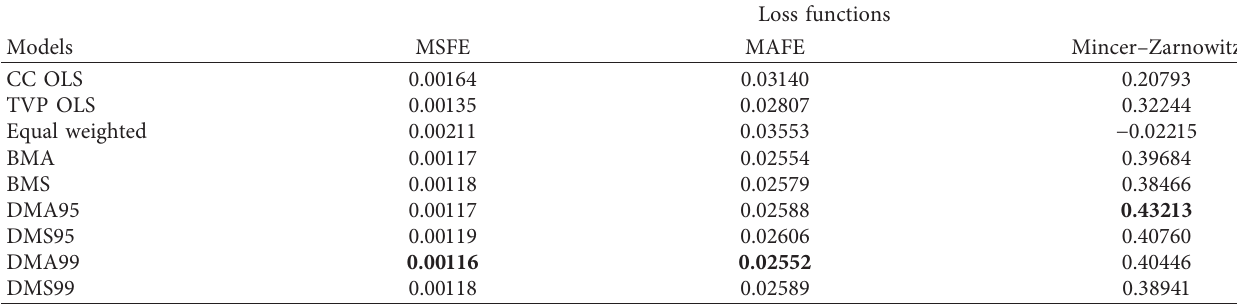
Table 3: Results of loss functions for different forecasting